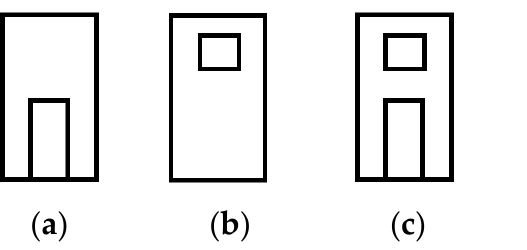
Figure 7. Slots used to model the facade ( a ) door (number 1), ( b ) window (number 2), ( c ) door and window (number 3).